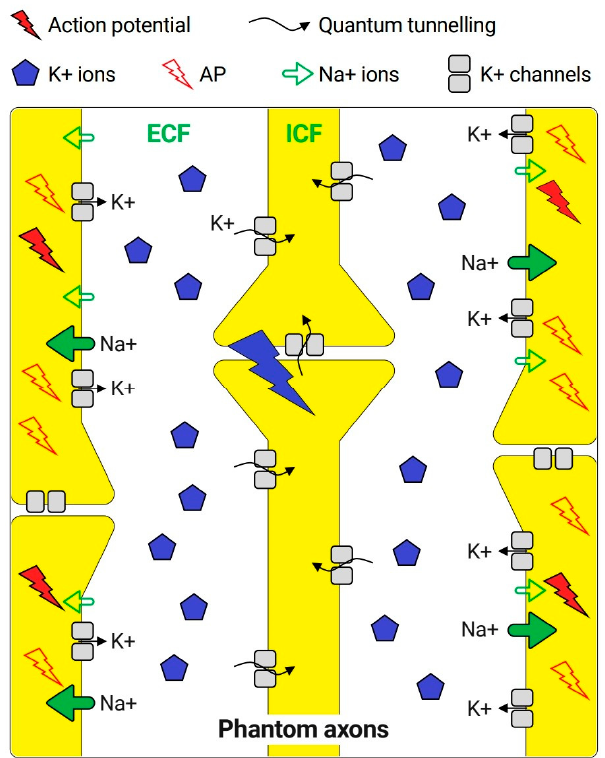
Figure 2. Simplifying the idea of potassium ions quantum tunneling as a consequence to hyperexcitability of adjacent nerves.